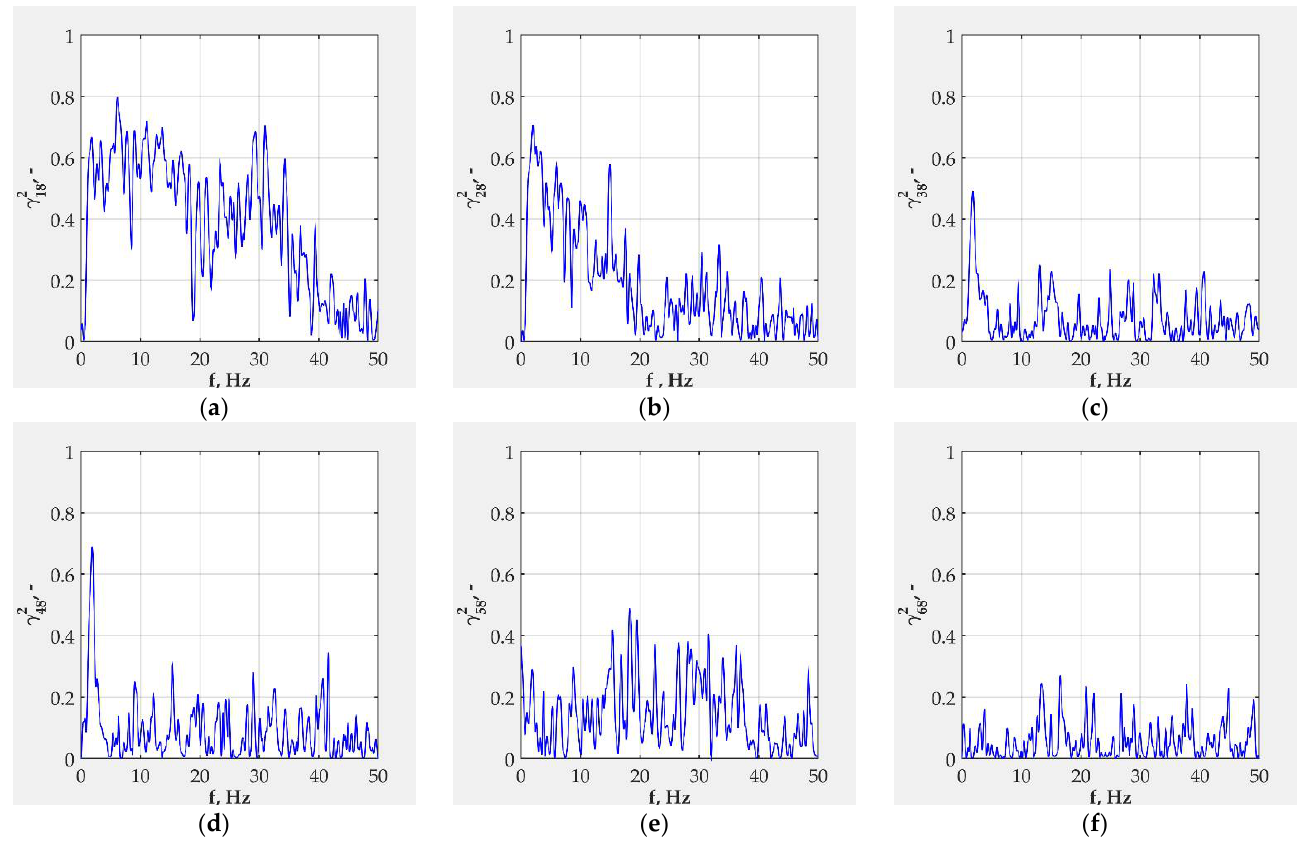
X for the transfer Figure 17. Ordinary coherence functions between the inputs and the output X 8 for the transfer 8 22 of 28